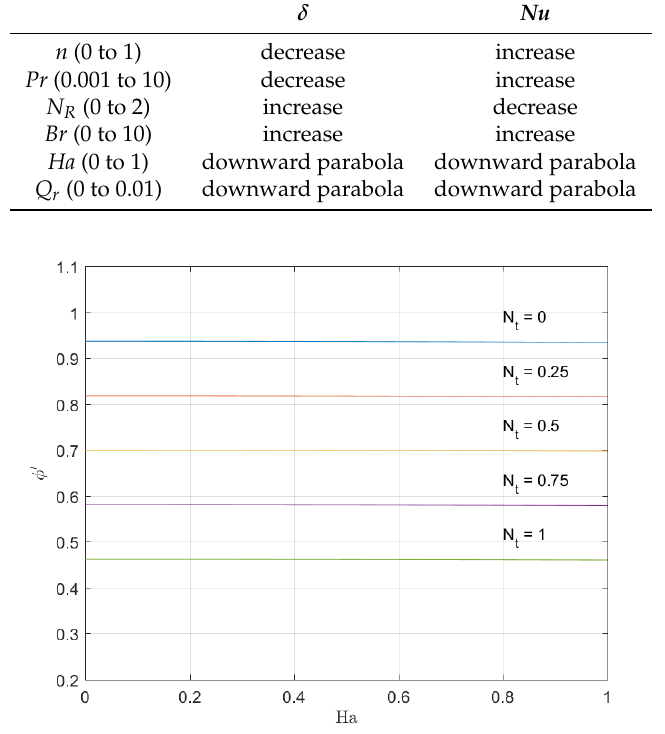
Figure 5. MHD and thermophoresis diffusion parameter effects on the rate of the chemical reaction in the boundary.